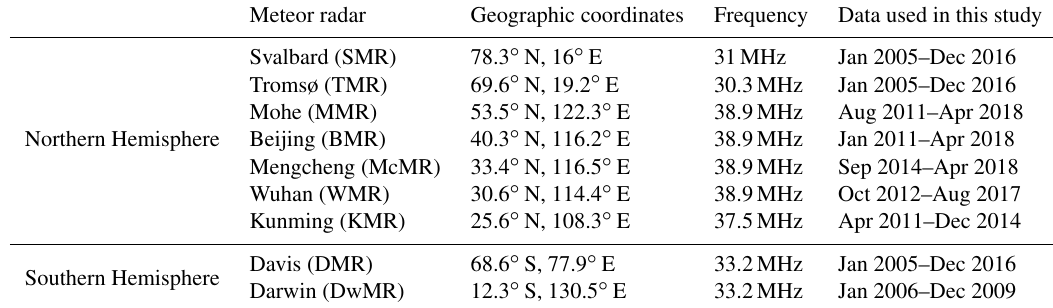
Table 1. Main operation parameters, geographic coordinates and observational time periods for the meteor radars used in this study. Meteor radar